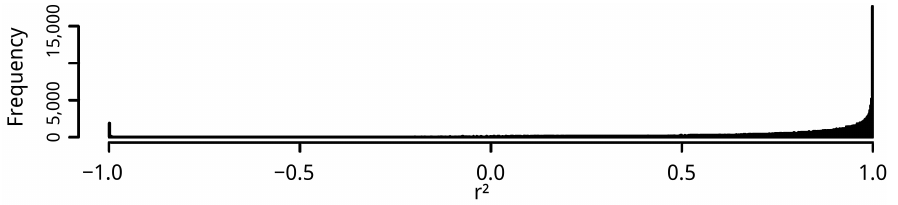
Figure 4. Frequency distribution of r 2 values for the comparison of LODES to all Twitter